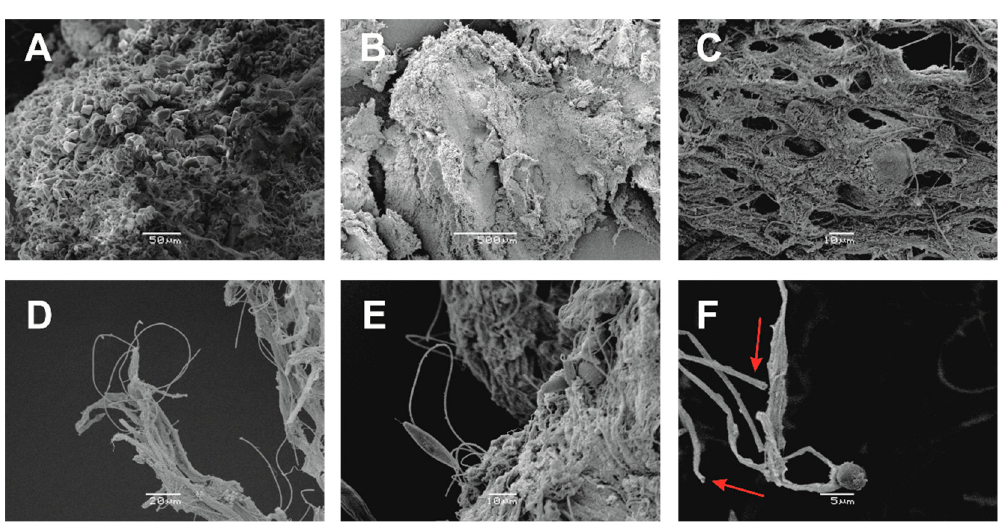
Figure 7. Biomineralizing processes by Cyanobacteria under SEM. ( A ) A top abiotic layer consisting of calcium carbonate crystals (scale bar: 50 μ m). ( B , C ) EPSs surfaces along with filamentous Cyanobacteria. ( B ) Overview of a dense EPSs layer (scale bar: 500 μ m). ( C ) Closer view in another position, where the EPSs form a net along with filamentous Cyanobacteria, favoring the trapping of calcium carbonate crystals and diatoms (scale bar: 10 μ m). ( D , E ) Details of filamentous Cyanobacteria which are developing upwards above the EPSs layer, favoring their trapping. In ( E ), a diatom is trapped (scale bar: 10 μ m). ( F ) Calcified sheaths of filamentous Cyanobacteria (scale bar: 5 μ m).